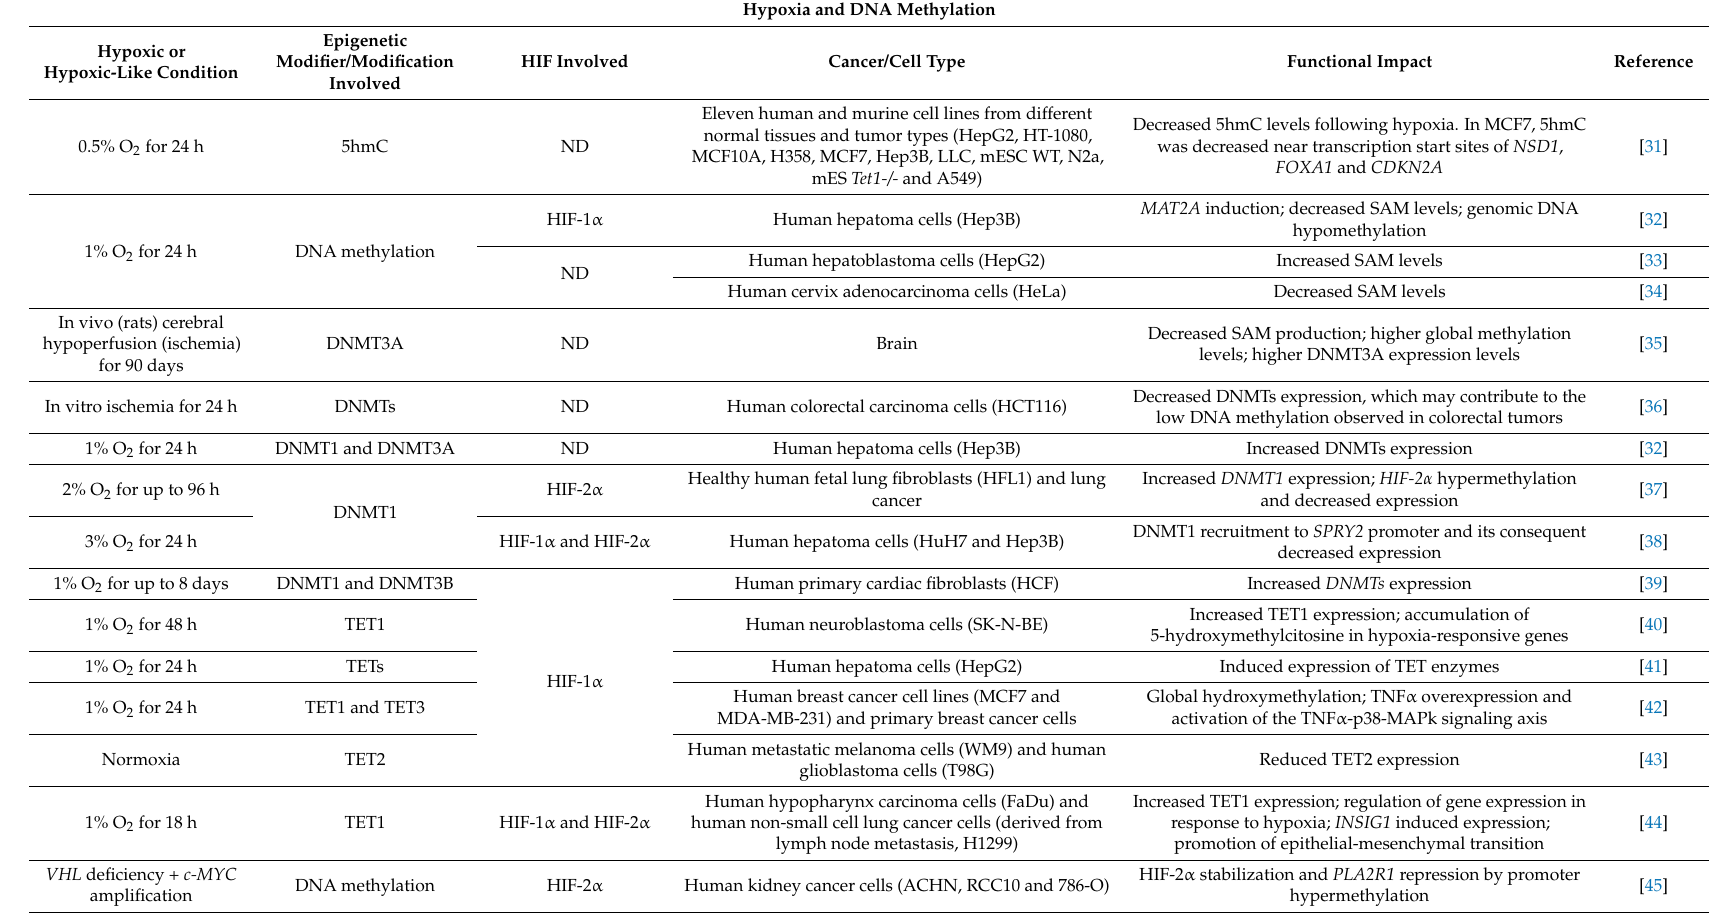
Table 1. Summary of epigenetics and hypoxia